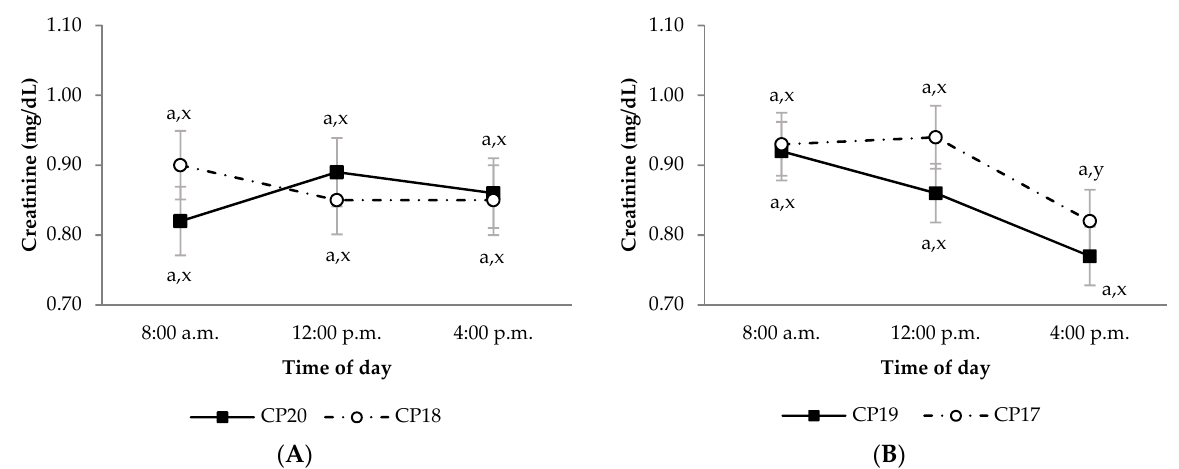
Figure 5. Plasma creatinine concentrations (mg/dL) in growing ( A ) and finishing ( B ) periods in Ripollesa lambs fed with different concentrations of crude protein were compared between treatments (CP20 vs. CP18 and CP19 vs. CP17) and time of day (least square mean values ± standard error). Within each sampling hour, different letters (a, b) denote statistical differences ( p ≤ 0.05) between dietary treatments. Within each dietary treatment, different letters (x, y) denote statistical differences ( p ≤ 0.05) between sampling hours.